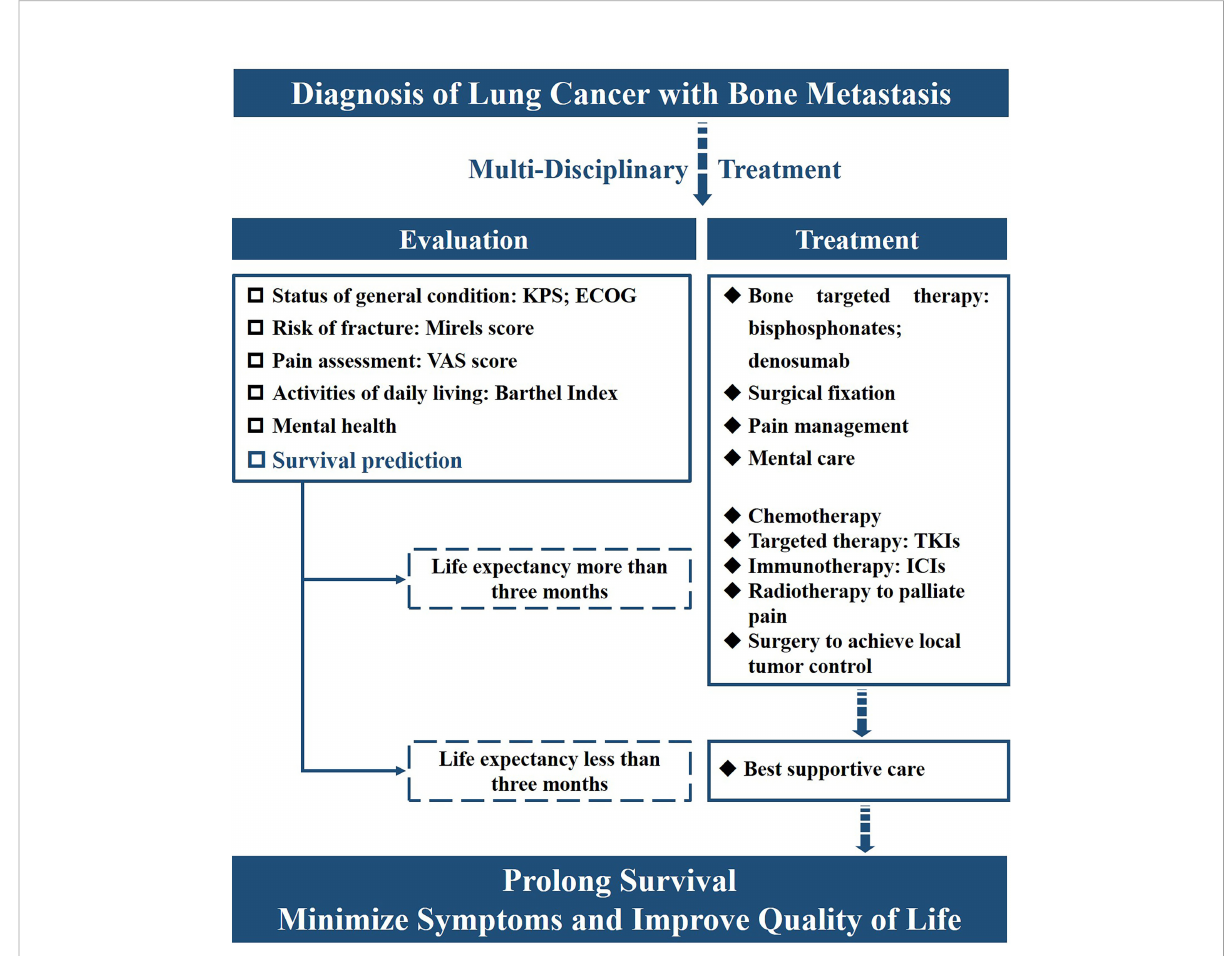
FIGURE 3 A fl owchart illustrating comprehensive evaluation and treatment strategies for lung patients with bone